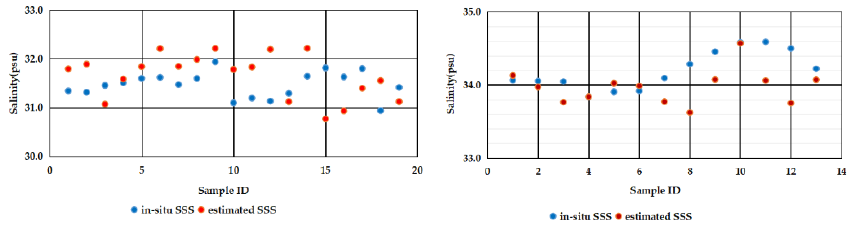
Figure 6. Comparison of in-situ SSS and estimated SSS. The broken lines of August ( left ) and April ( right ) were shown in the chart.